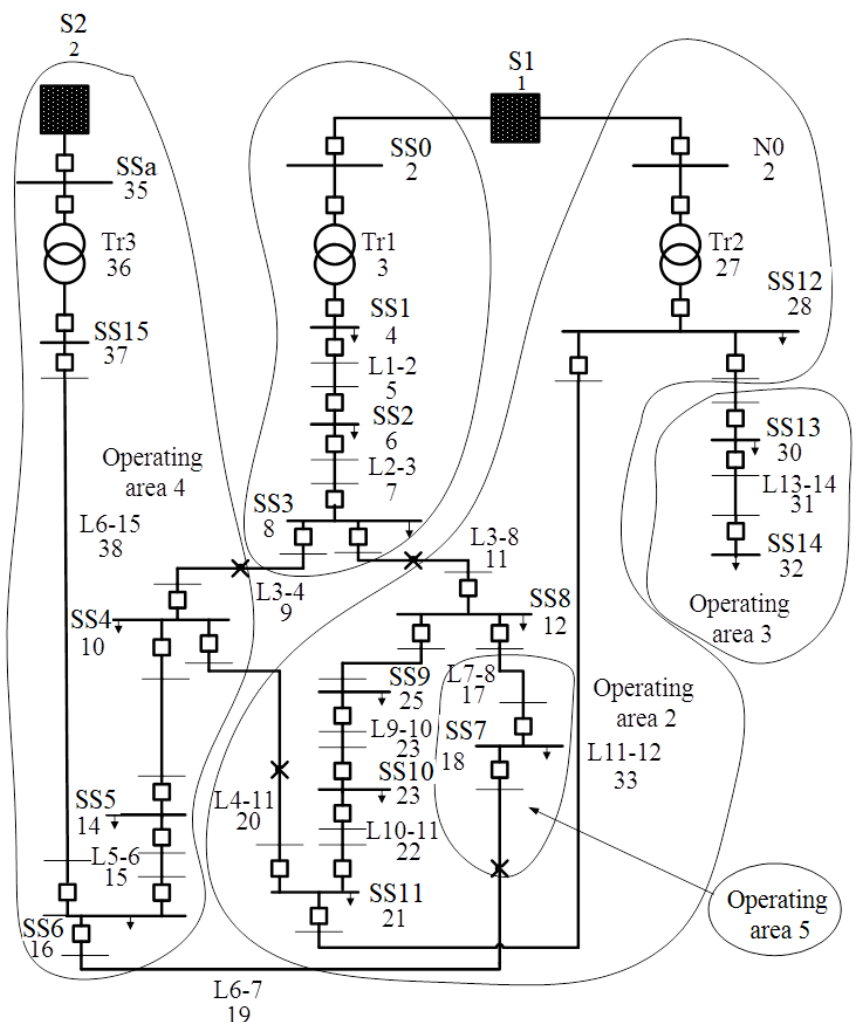
Figure 12. Reconfigured distribution network with operating areas.